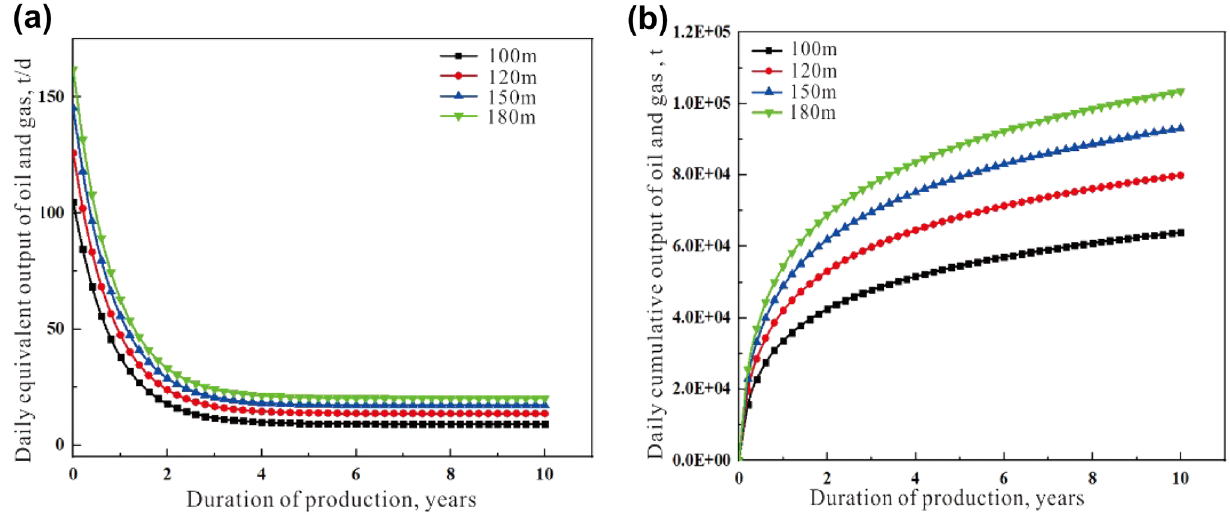
Fig. 3 Daily ( a ) and cumulative ( b ) output under the different half-lengths of